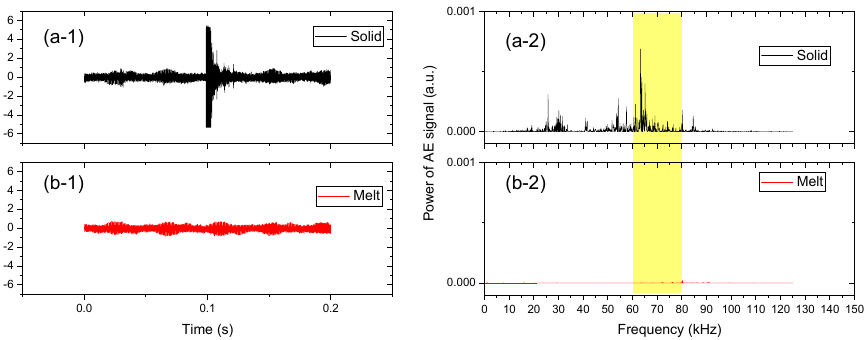
Figure 3. Time domain AE signals at a barrel temperature of ( a − 1 ) 30 °C and ( b − 1 ) 195 °C. Power of AE signals in frequency domains at ( a − 2 ) 30 °C and ( b − 2 ) 195 °C. The screw rotation speed and feed rate were 50 rpm and 2.0 kg/h, respectively.